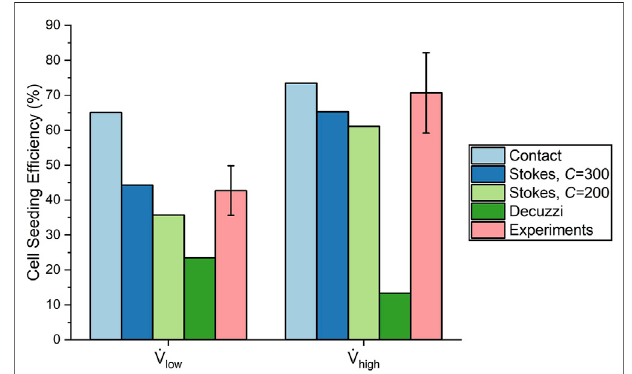
FIGURE 10 | Comparison of cell seeding ef fi ciency from each cell deposition algorithm and experiments.